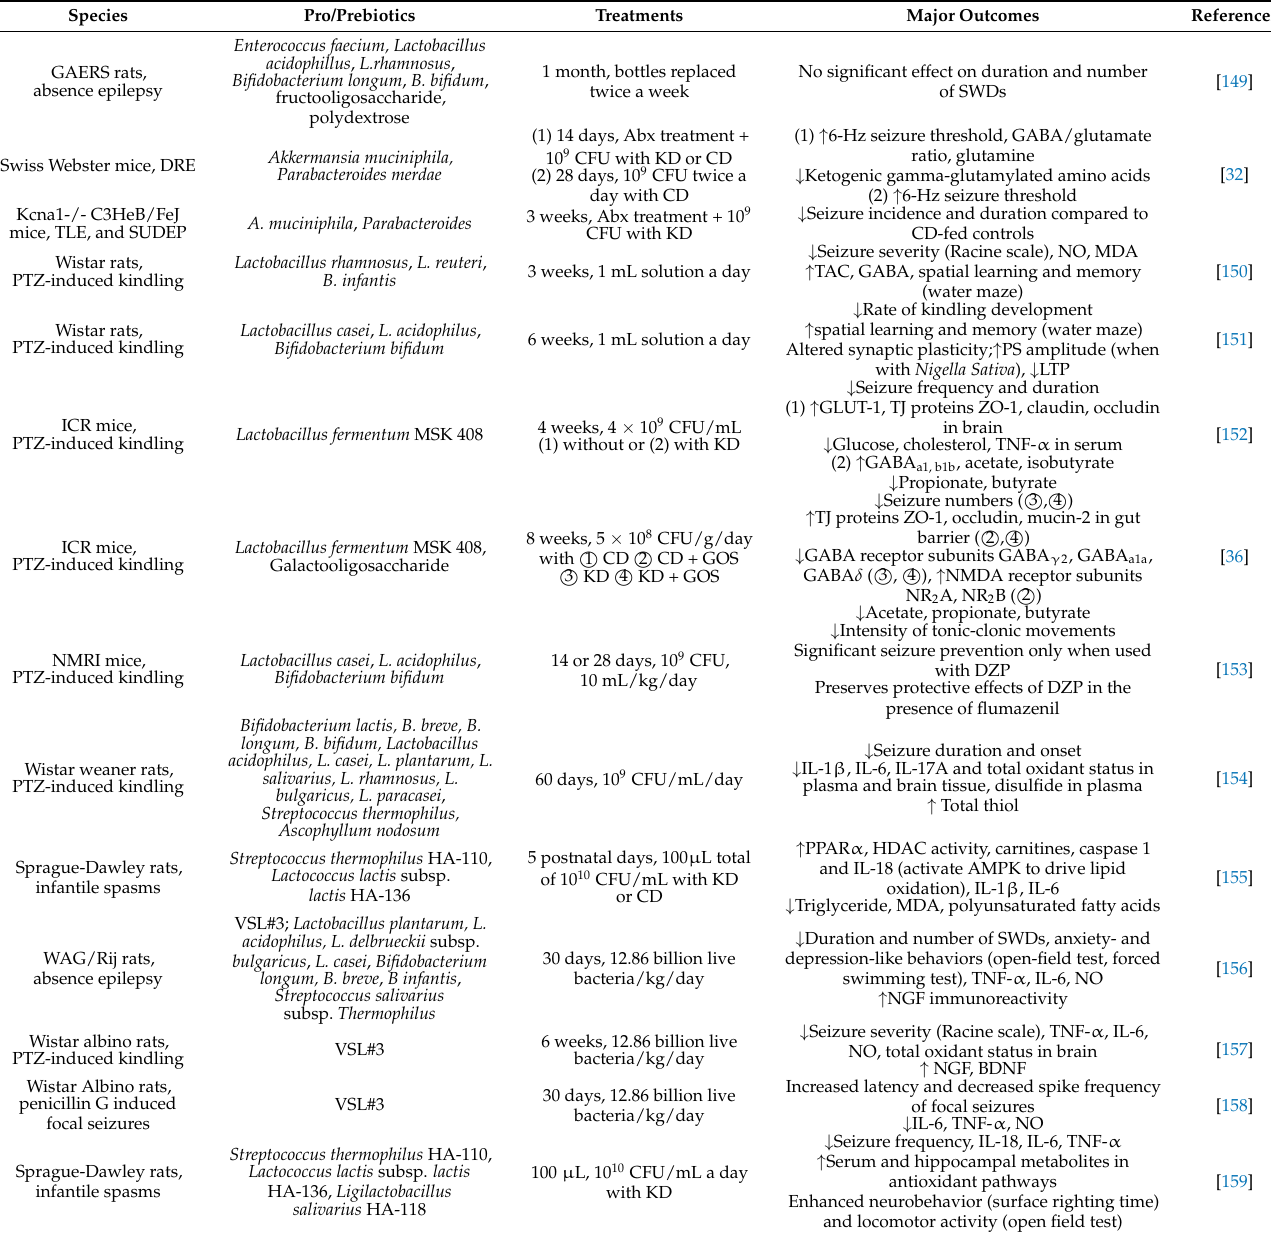
Table 3. Preclinical trials on the effects of pro/prebiotics on epilepsy, in published